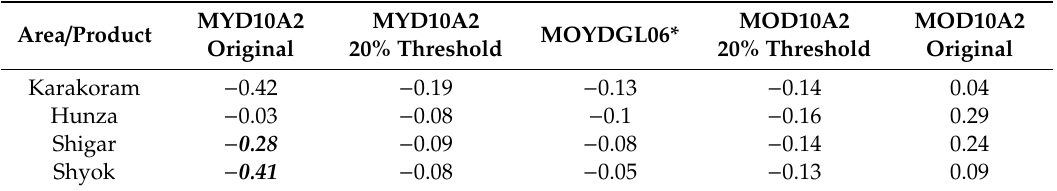
Table 3. Annual average snow cover trends (% per year) in the Karakoram region and subbasins. Italic bold numbers are statistically significant at the 90% confidence